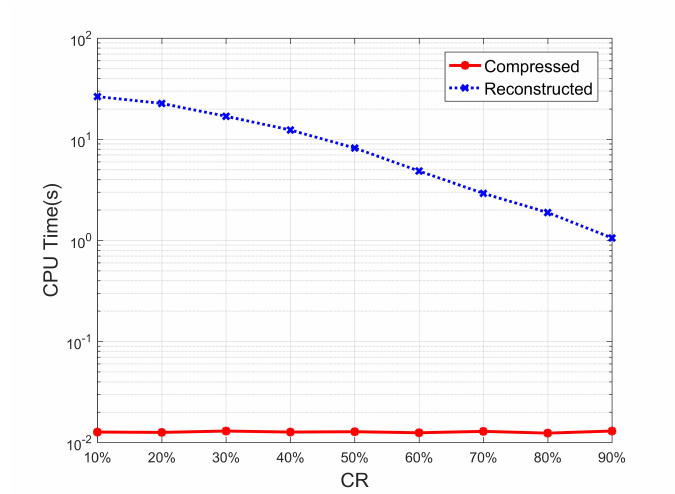
Figure 4. Average CPU time of AF detection from compressed ECG and reconstructed